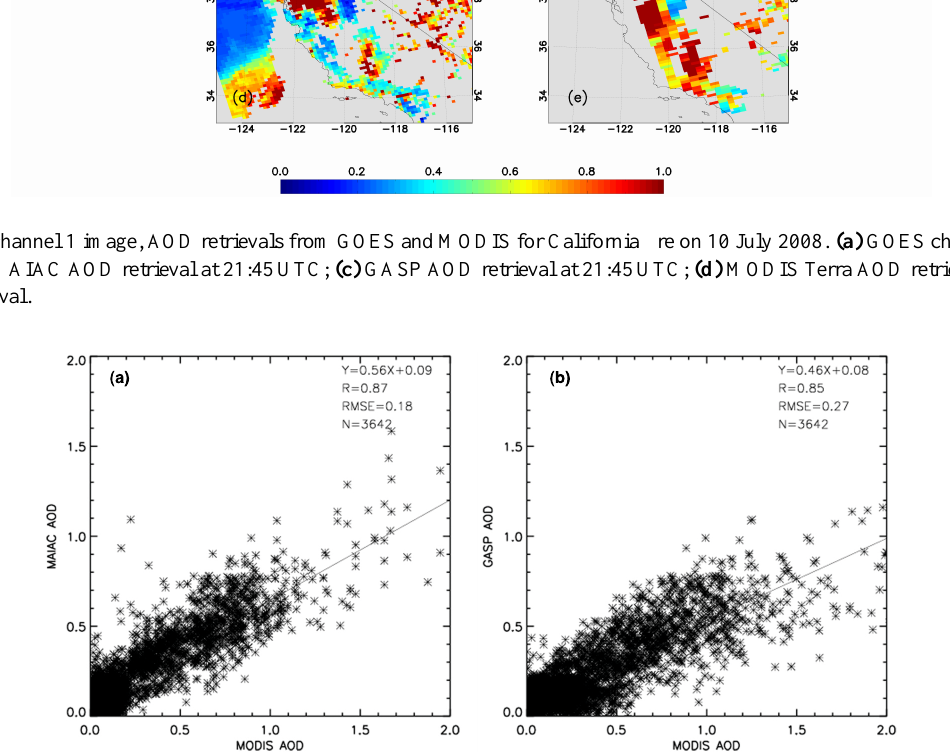
Fig. 12. Scatter plot of GOES AOD vs. MODIS AOD from Aqua for the California fire on 10 July 2008 at Aqua overpass time. (a) MAIAC AOD vs. MODIS AOD from Aqua; (b) GASP AOD vs. MODIS AOD from